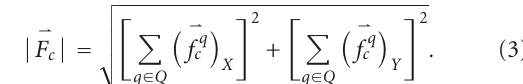
where k is a constant, E q is the residual energy of the quasi- hotspot q , and D q is an estimate distance from q to the edge of the network, which is used to estimate the forwarding workload of the quasi-hotspot q if the energy mower stays at the position c . The direction of the influence force lies in the same direction from q to c , which is illustrated in Figure 2.